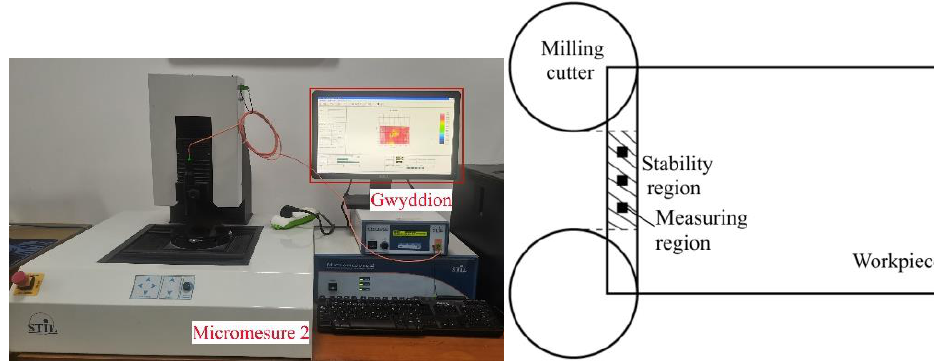
Figure 4. Surface roughness measurement equipment and method.